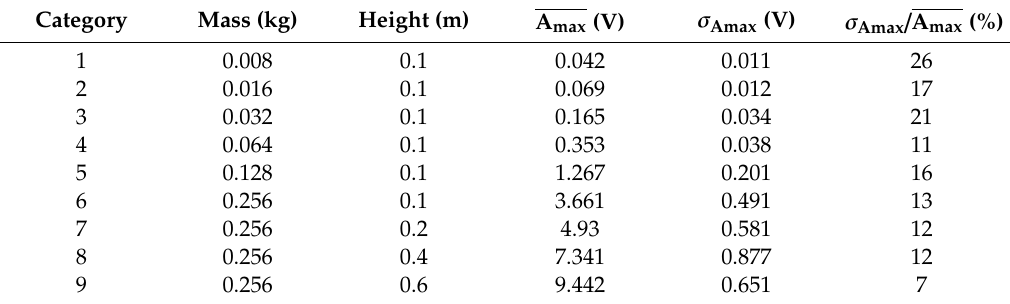
Table 2. Mean and standard deviation (10 impacts) for each of the nine categories of drop weight-height that were retained from the laboratory experiment to be conducted in the